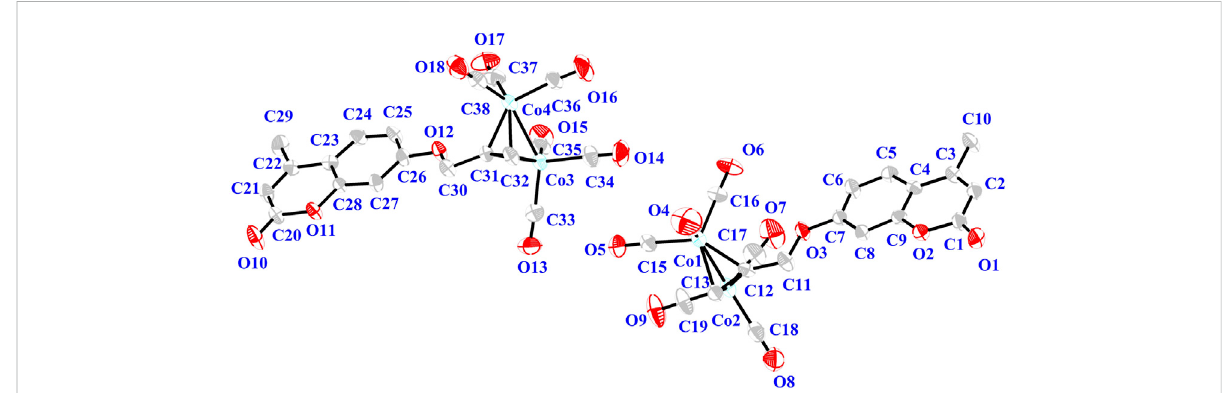
FIGURE 1 Thermal ellipsoid plot ofthe cationof complex5 shown with 30% probability ellipsoids. Hatomsand thecounterion areomitted for thesake of clarity.